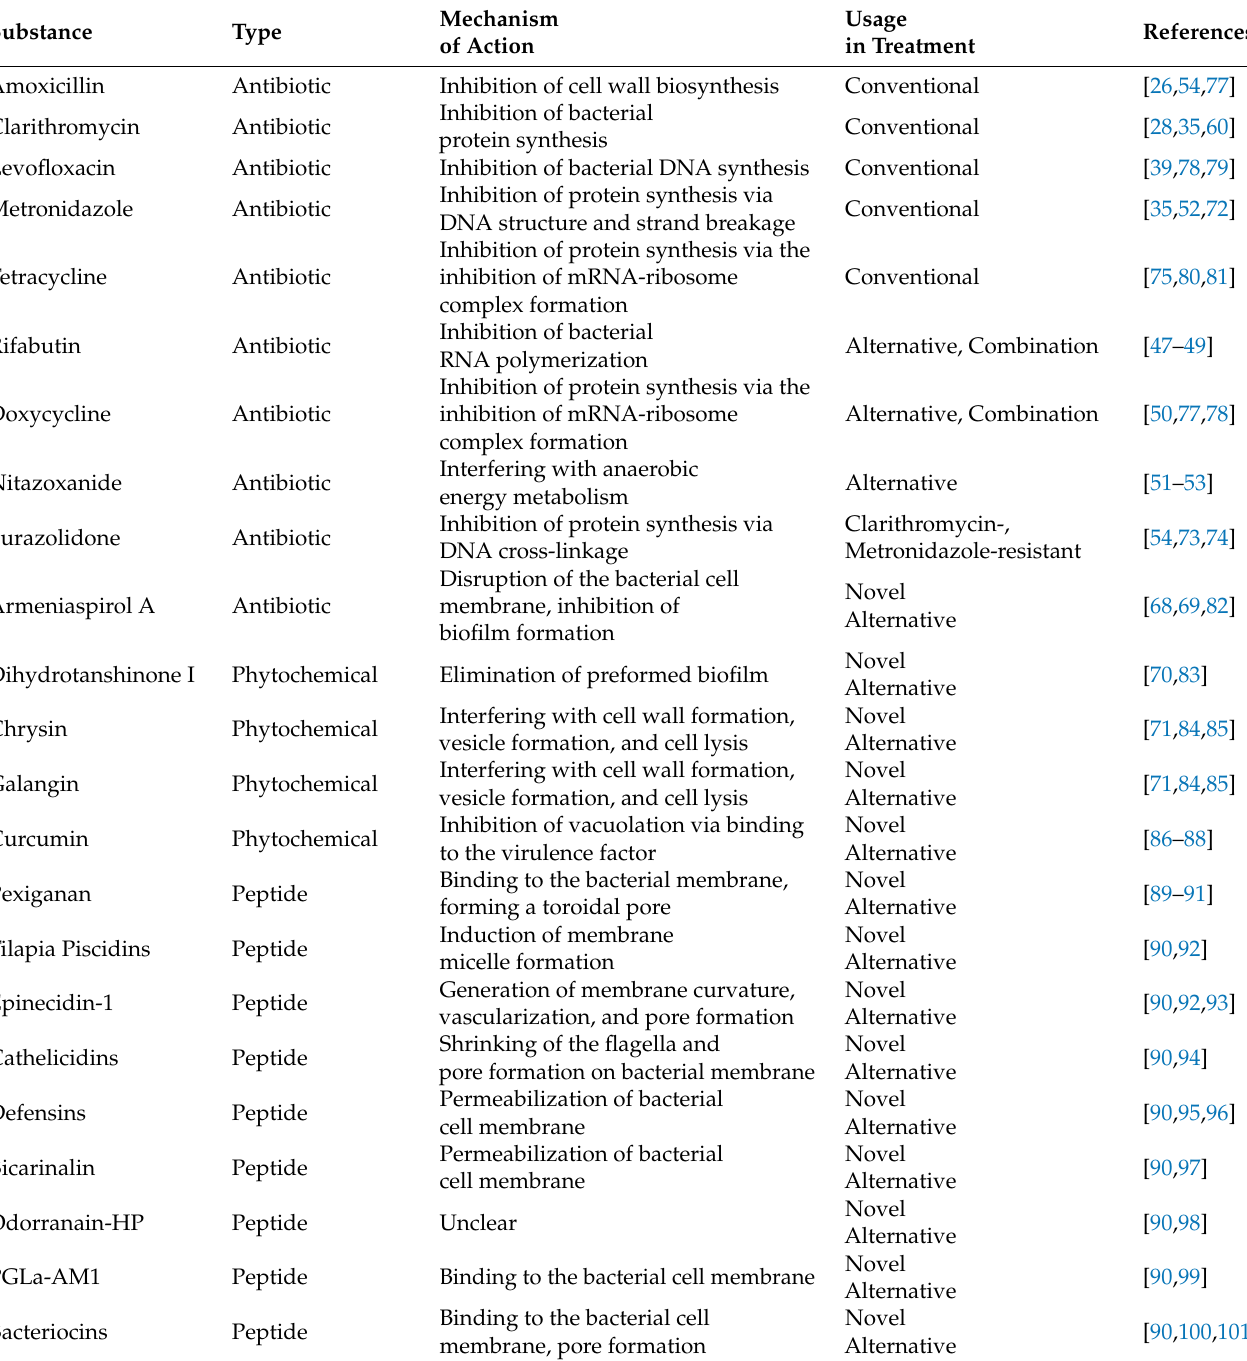
Table 1. Conventional, alternative, and novel treatment options for Helicobacter pylori